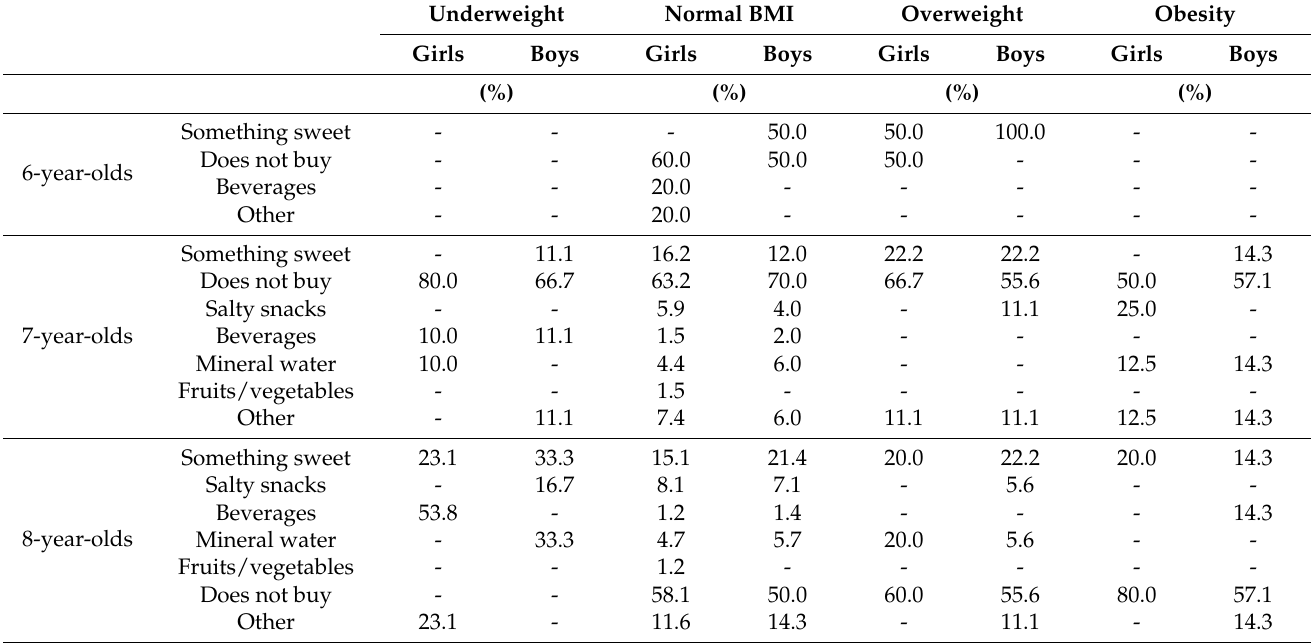
Table 7. Products purchased from the school shop by girls according to age and nutritional status.